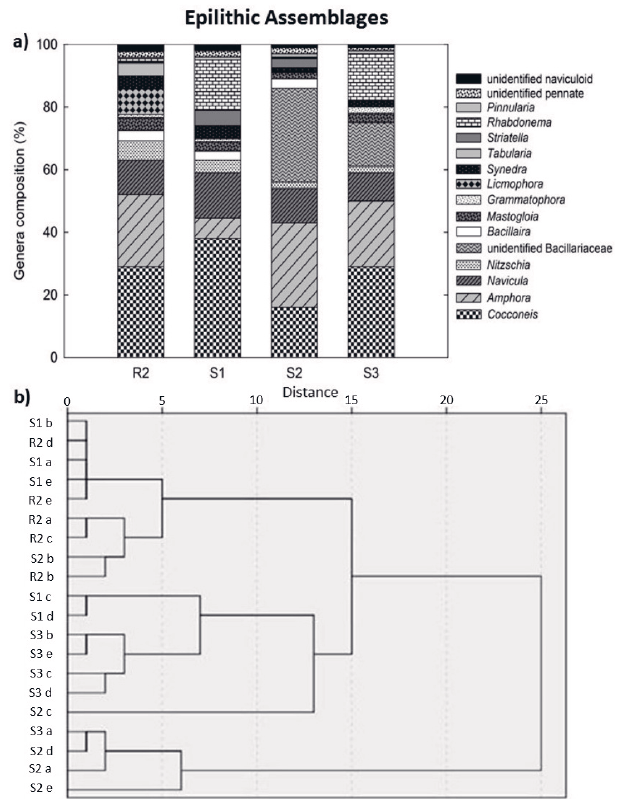
Figure 5. Epilithic diatom assemblages along a natural CO 2 gradient. ( a ) Relative composition of epilithic assemblages at different p CO 2 levels. Bar charts include all genera present over 1% and all unidentified diatoms grouped as unidentified pennate or naviculoid ( n = 5 per station,); ( b ) Hierarchical cluster analyses of the similarity of epilithic diatom assemblage composition based on Ward’s method with squared Euclidian distance for all the biofilms sampled along a natural CO 2 gradient ( n = 20). Analysis consists of all genera present over 1%, including any of the unidentified